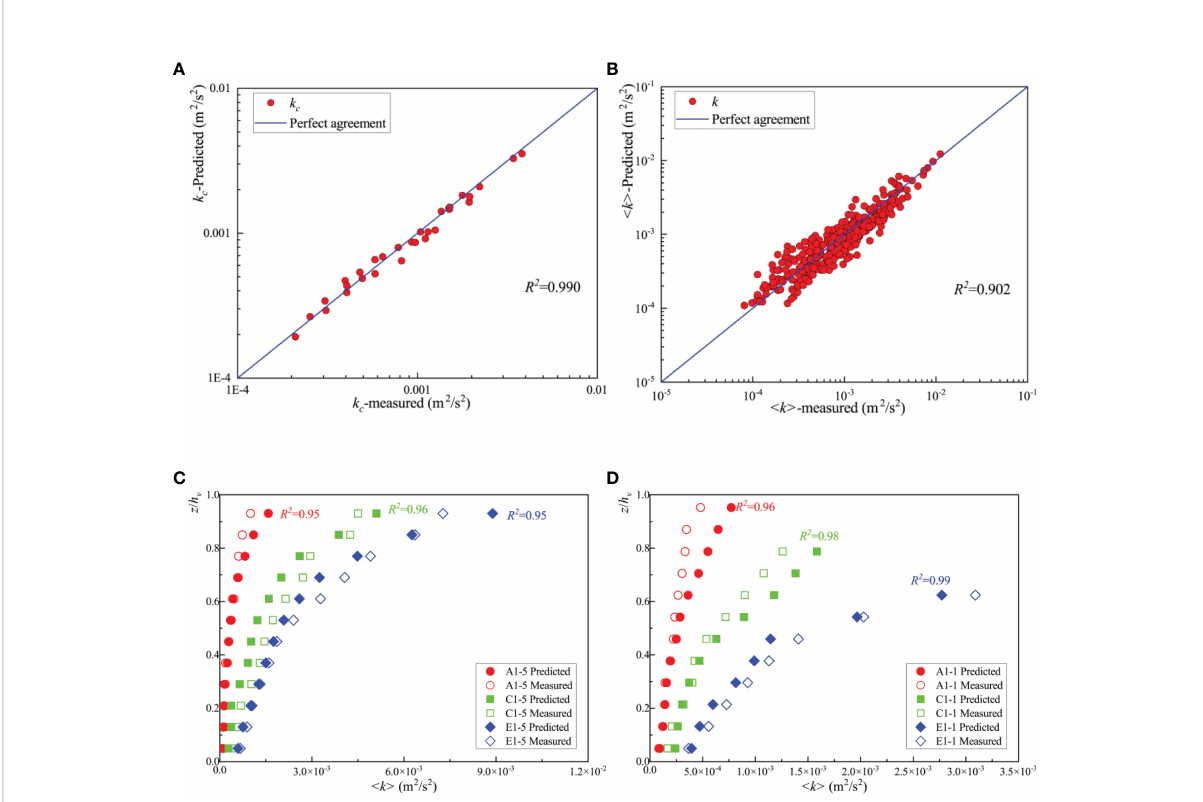
FIGURE 15 (A) Comparison of predicted and measured values of the vegetation canopy-averaged turbulent kinetic energy k c ; (B) comparison of the predicted and measured values of the local turbulent kinetic energy 〈 k 〉 within the vegetation canopy for all 30 test conditions; (C, D) comparison of predicted and measured values of the local turbulent kinetic energy 〈 k 〉 within vegetation canopy along the vertical direction under different